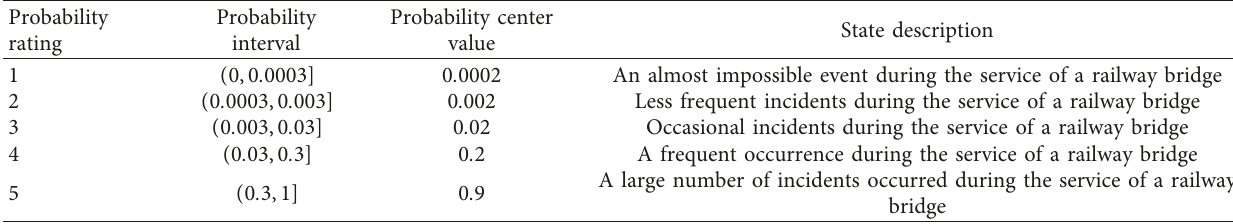
Table 6: Root node occurrence probability grade standard.